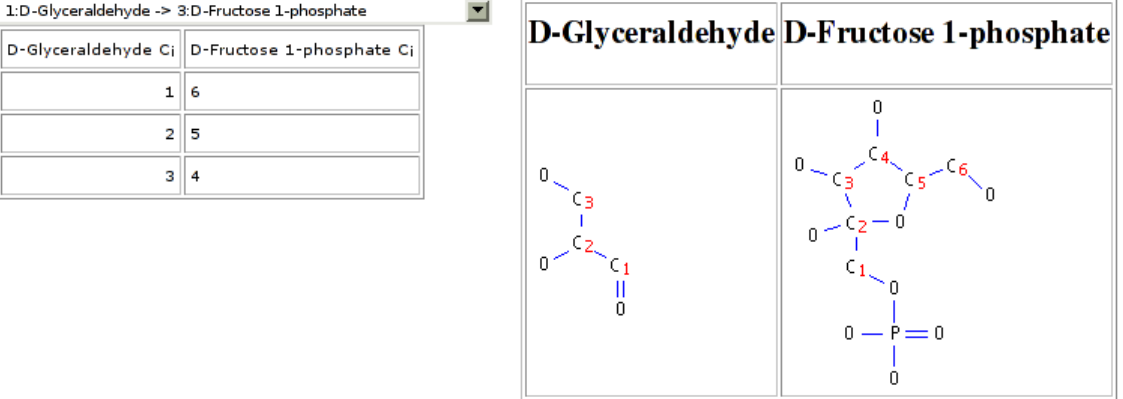
Figure 2: The mapping of carbon atoms between D-Glyceraldehyde and D-Fructose 1-phosphate in the fructose 1-phosphate aldolase reaction (EC 4.1.2.13) as seen in ReMatch. Here the carbons (1, 2, 3) in D-Glyceraldehyde are mapped to carbons (6, 5, 4) in D-Fructose 1-phosphate. ReMatch provides carbon mappings for many reactions through the ARM database, and also easy-to-use tools for adding new user-defined carbon